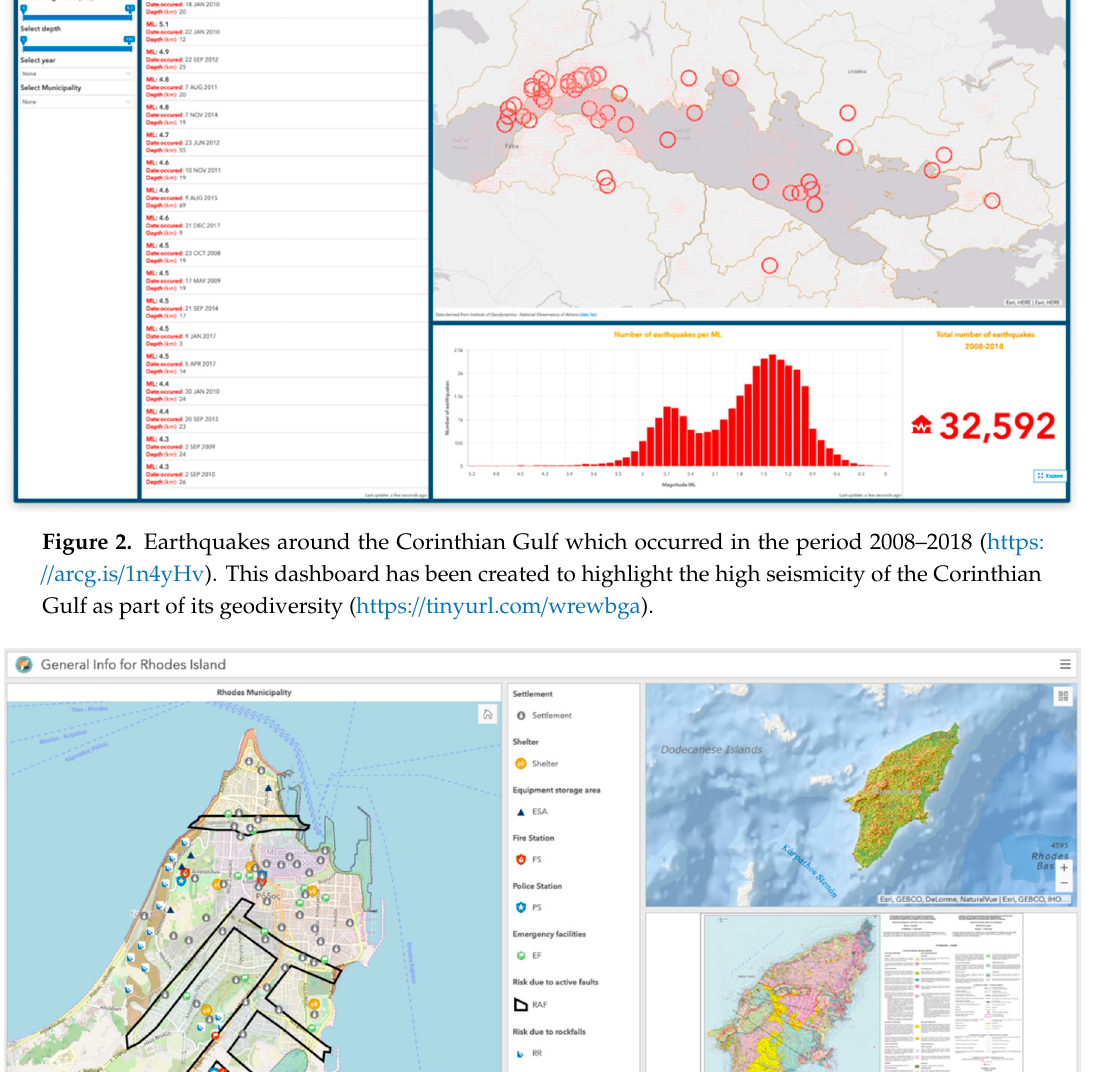
Figure 4. Interactive dynamic dashboard presenting real-time damage to infrastructure and casualties during an earthquake event (https://arcg.is/0LSmHj). Apart from authorities being prepared during a natural hazard event, action must also be taken for the dissemination of scientific information to general public. As the sense of vision is the most dominant one, most people prefer to receive information through images and video. They also perceive their surroundings as they browse through maps by giving credence to features within them and putting complex environments in order through the recognition of patterns and relationships. Thus, organizing information about an area spatially offers a unique ability to visualize it while at the same time providing a useful and dynamic way of collecting information—a process the user can interact with. In addition, maps can be quite attractive, stimulating both sides of the brain: the right side, which is intuitive and aesthetic, and the left, which is logical and analytical, making a successful combination of utility with beauty, which proves to be appealing to the end-user. Story maps are a new approach for data dissemination, as they use geography as a means of organizing and illustrating data, presenting narrative information about a place, an event, a subject and more by using a geographical frame and combining interactive maps with text, photos, videos and audiovisual media. Therefore, maps and narration complement each other in one application,